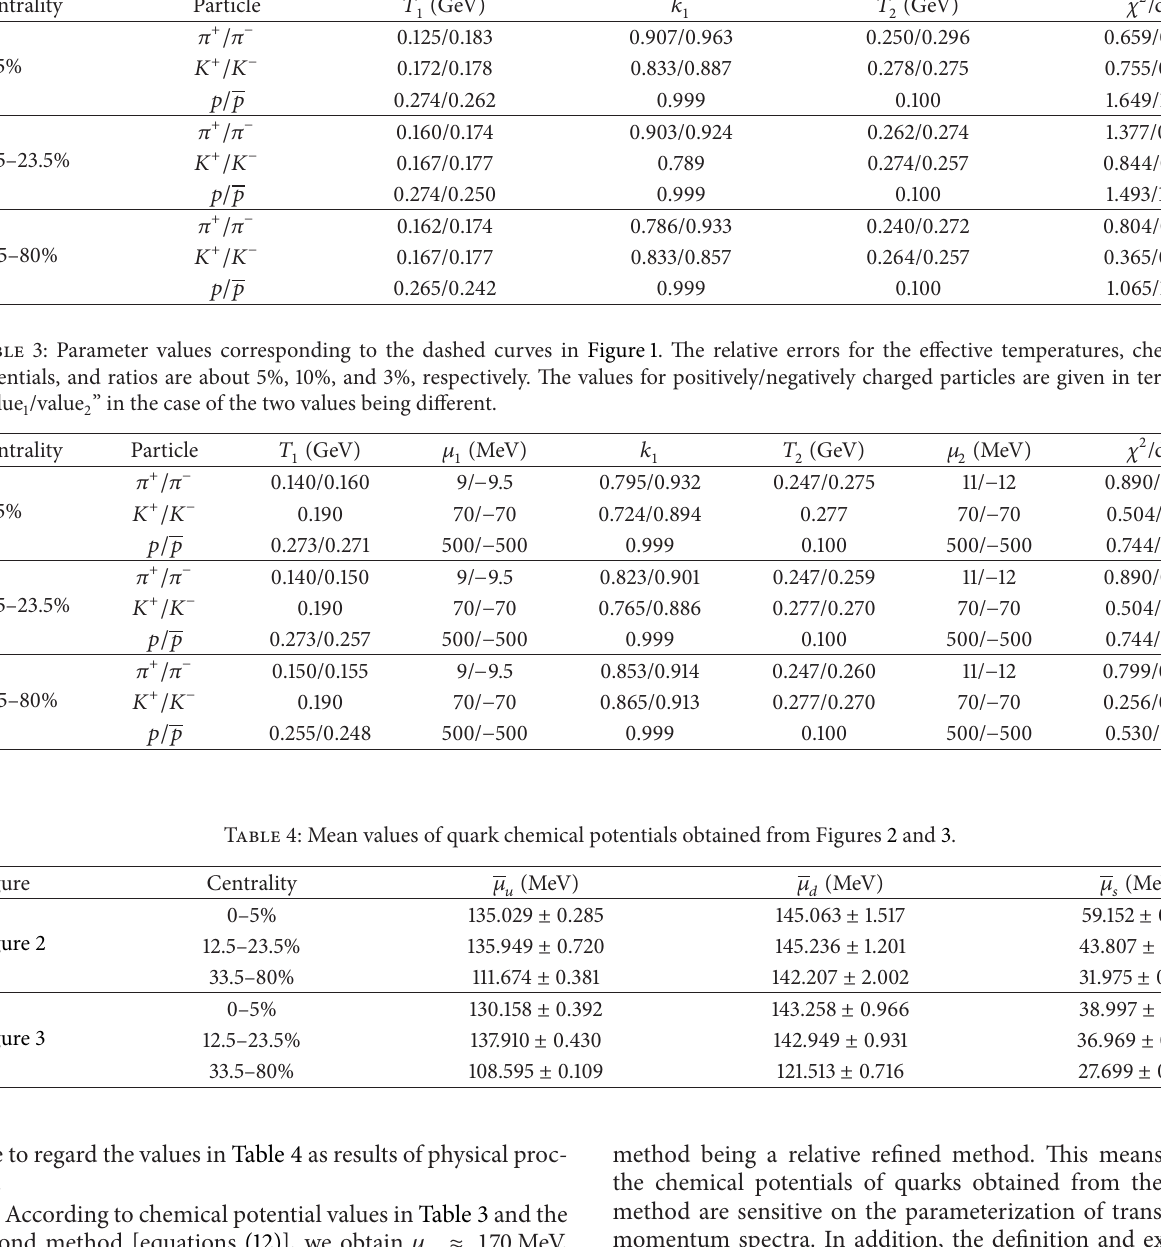
/value ” in the case of the two 1 2